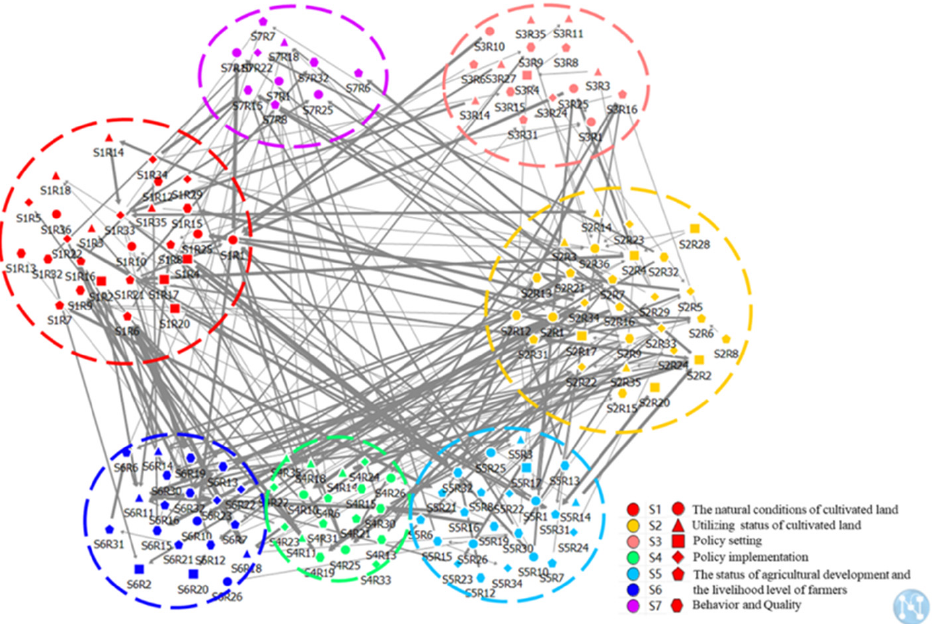
Figure 3. Network visualization graph of stakeholders. Note: S1, village committee; S2, local government; S3, land-use organization; S4, land non-flow farmers; S5, land flow-in farmers; S6, land flow-out farmers; and S7, the public.